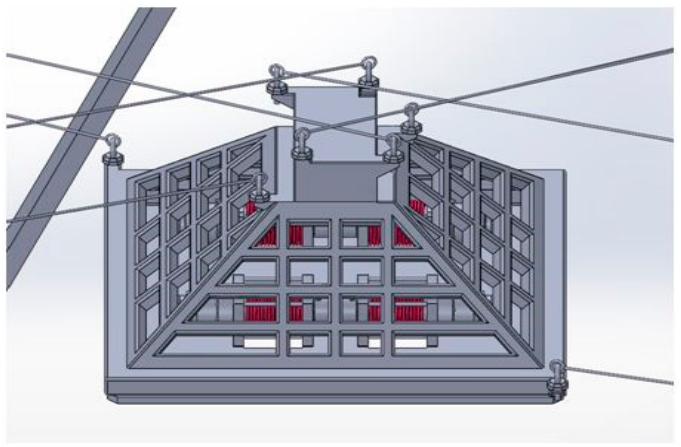
Figure 3. Cuboid details. Eight winches have the role of controlling these eight cables. These are controlled and coordinated by a computer. The motion of the platform is controlled by an operator through a six-axis joystick with six DOFs. The operator can handle and manipulate the trunk and any load attached to it over a large volume of work inside the